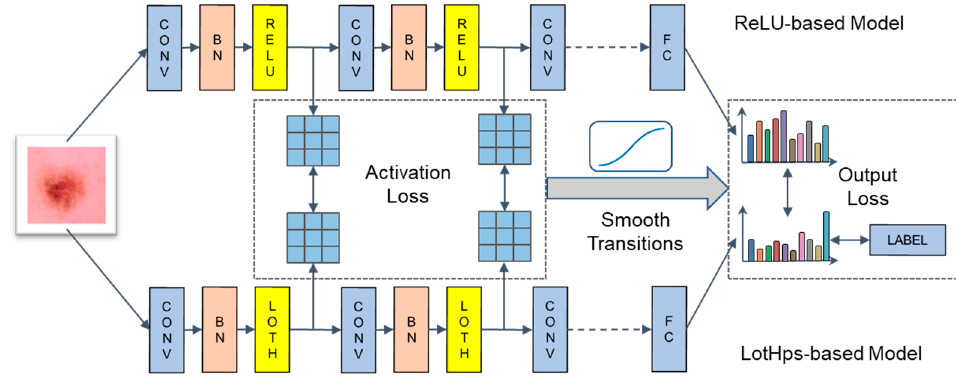
Figure 3. Variable-weighted di ff erence training (VDT) schematic.